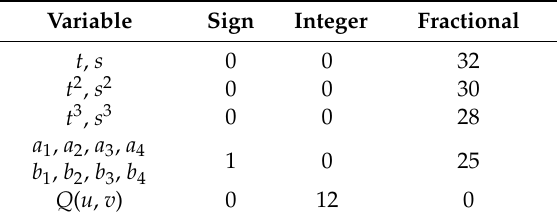
Table 2. Data structures of fixed-point